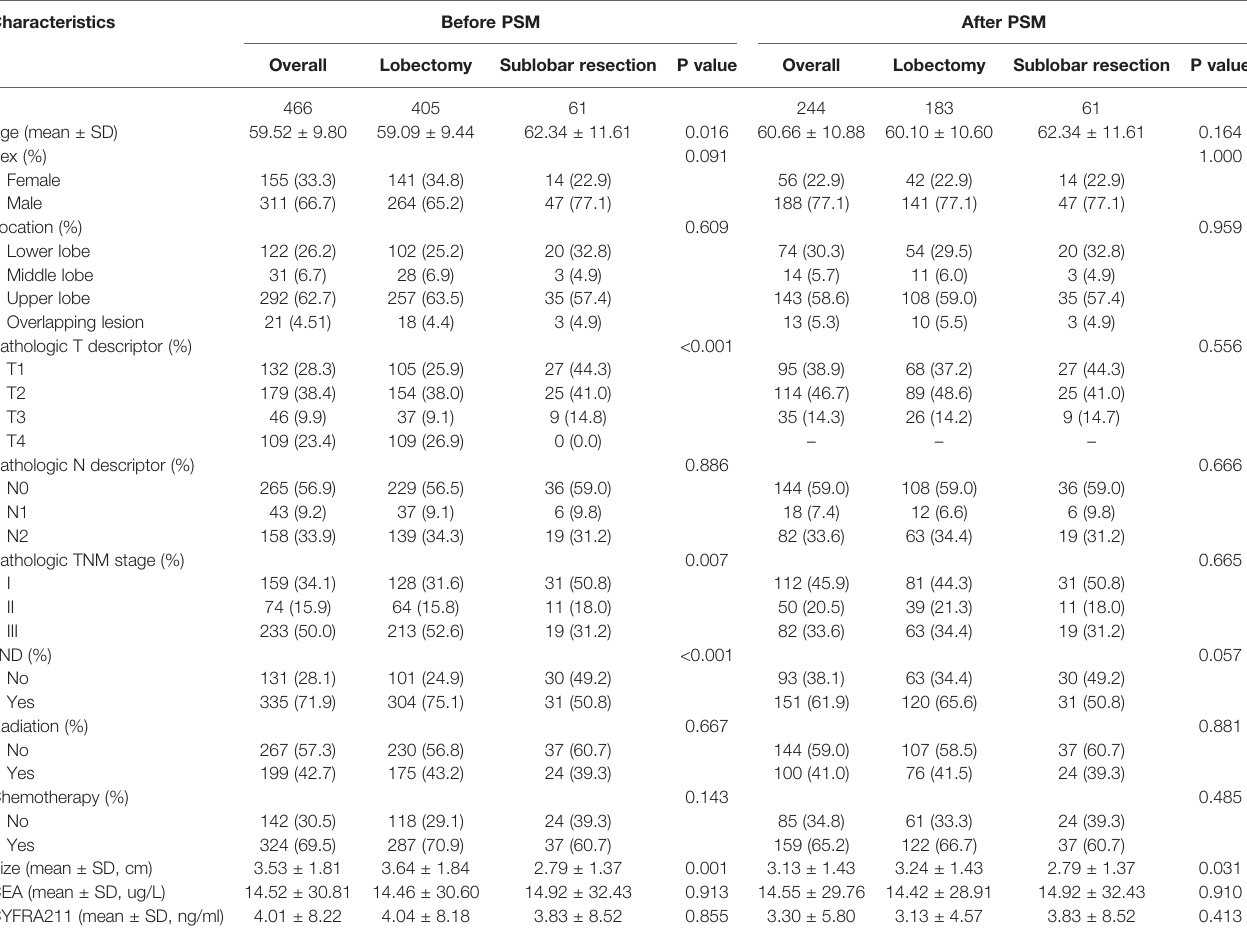
TABLE 2 | Baseline characteristics of the SPH cohort before and after PSM. Characteristics